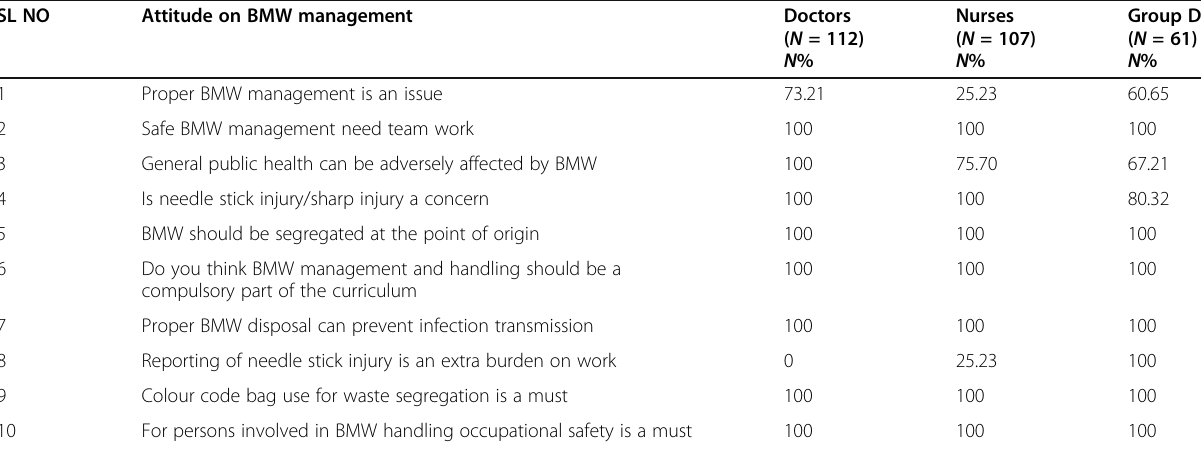
Table 2 Attitude of health care workers on BMW management